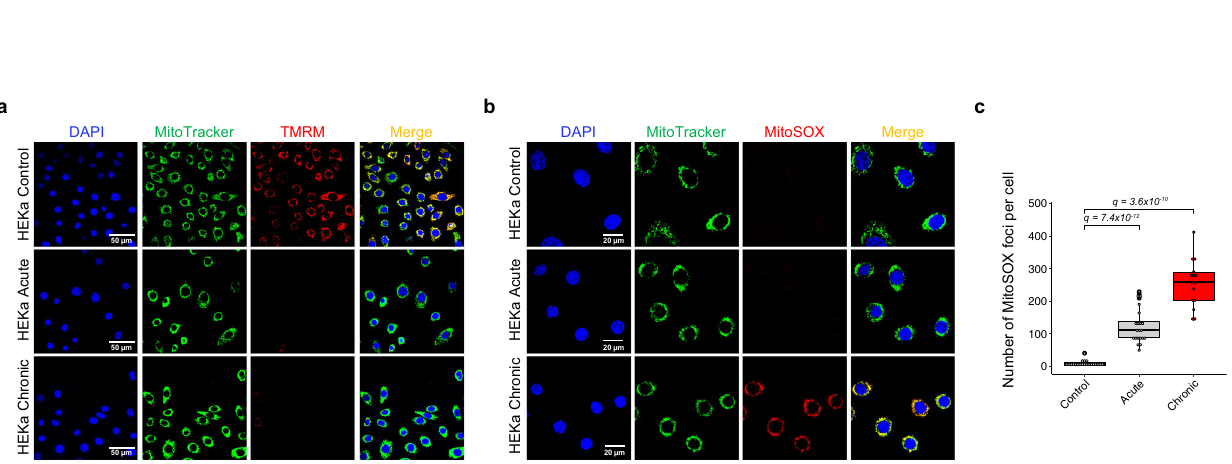
Fig. 4 | Mitochondrial disruptionafter irradiationwitha UV-nail dryerinHEKa cells.a Evaluatingthe mitochondrialmembrane potentialafterirradiation of HEKa cells with a UV-nail dryer. DAPI is shown in blue, MitoTracker in green, and tetra- methylrhodamine dye (TMRM) in red. Yellow corresponds to overlaps between MitoTracker and TMRM. Images collected from three independent experiments. b Examining mitochondrial ROS production in HEKa cells. DAPI is shown in blue, MitoTrackeringreen,andMitoSOXinred.Yellowcorrespondstooverlapsbetween MitoTrackerandMitoSOX.Inboth( a )and( b ),MitoTrackergreenreagentisusedto